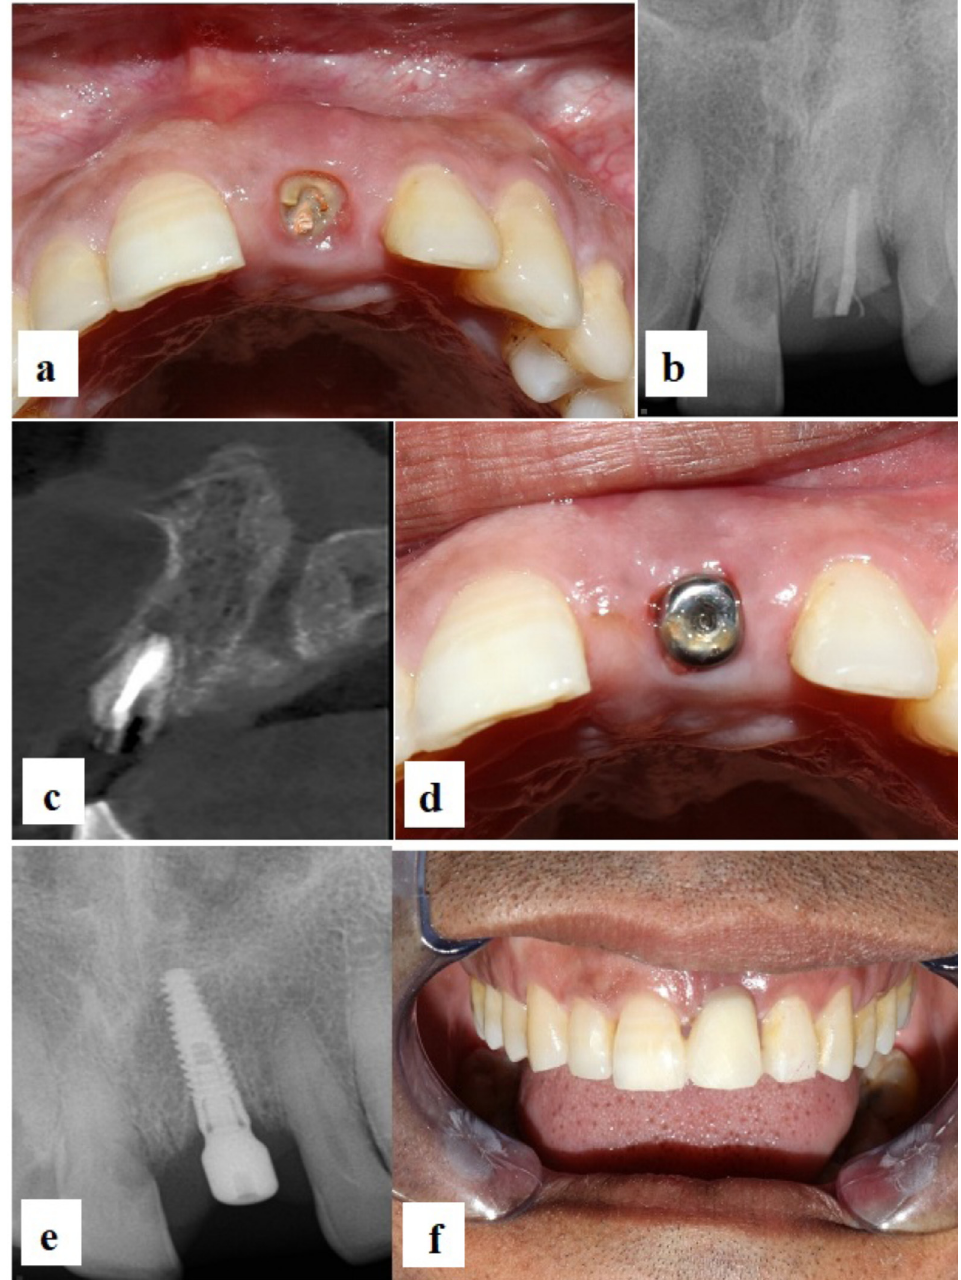
Fig. 1. A case with immediate implant placement with dropping of primary stability to zero insertion